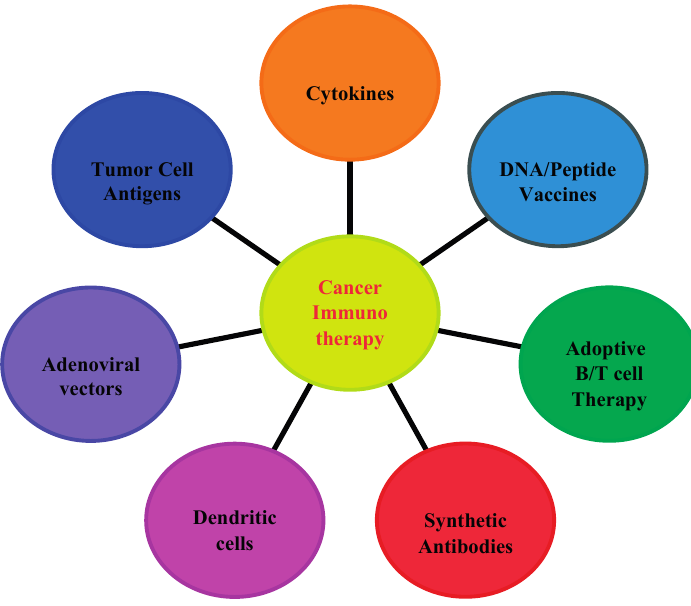
Figure 1. Current immunotherapeutic strategies used in cancer